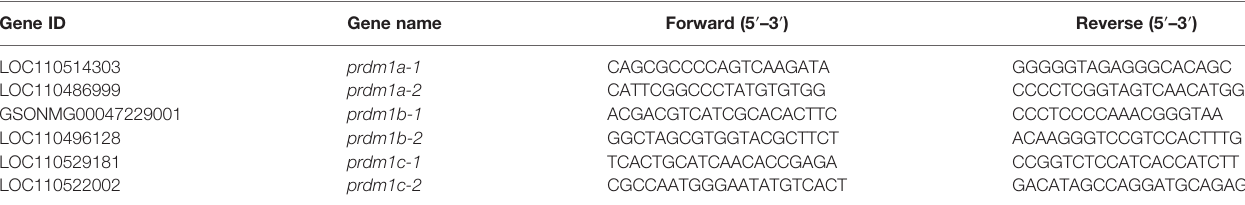
TABLE 1 | Primers used in real time